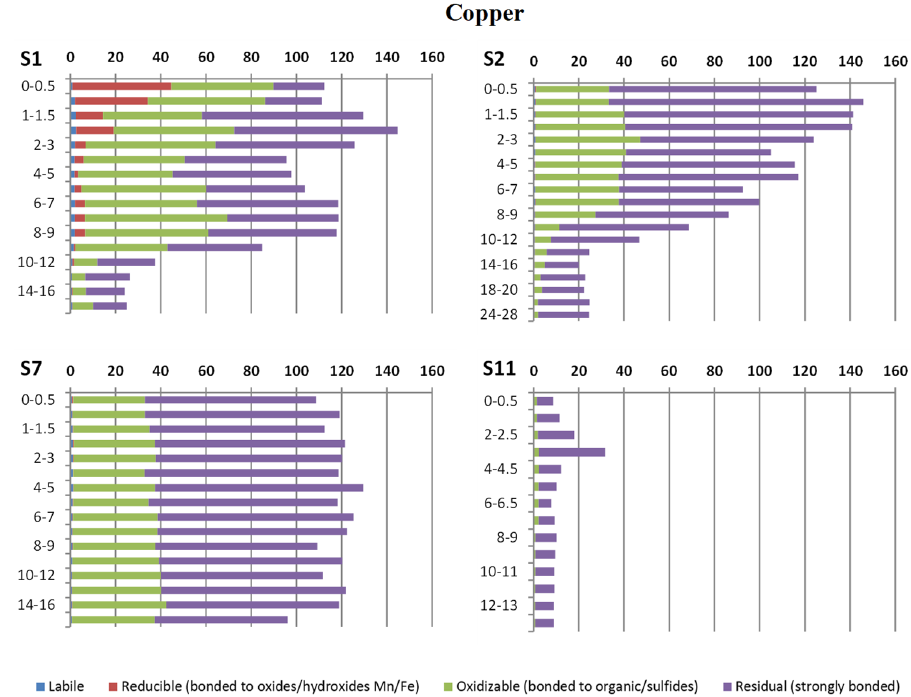
Figure 5. Chemical fractionation of Cu in sediments from the S1, S2, S7, and S11 stations. Horizontal axis: concentration (mg/kg). Vertical axis: core depth (cm).